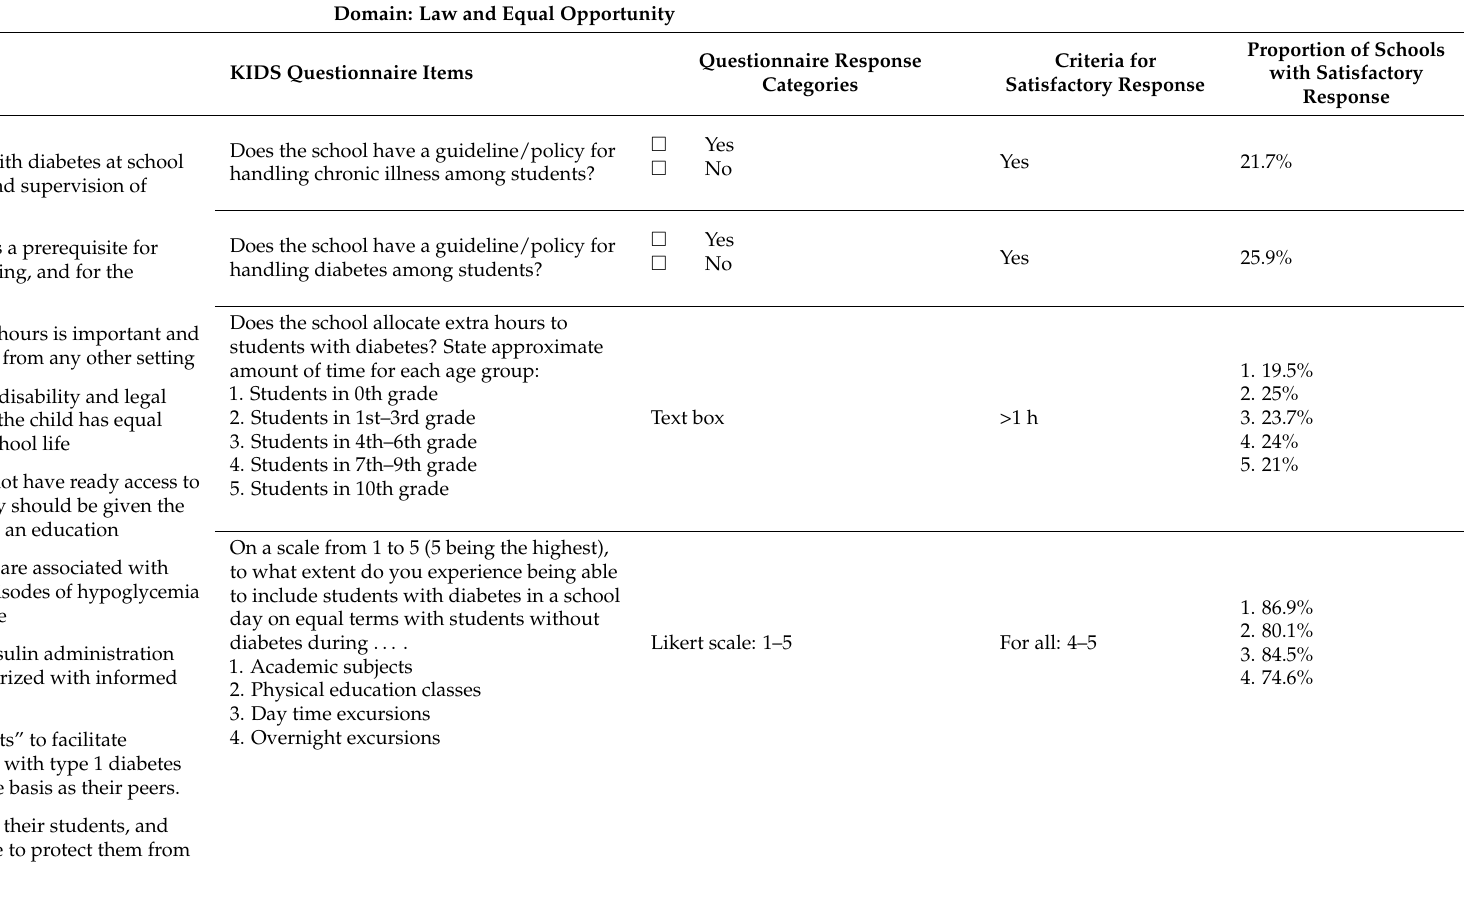
Table A1. Overview of the ISPAD guidelines, KIDS questionnaire and satisfactory responses, ( n =